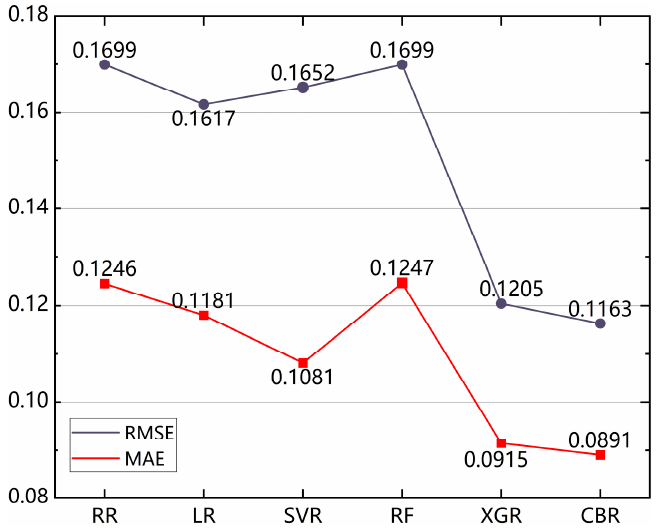
Figure 11. RMSE and MAE scores of the six regression models trained in all datasets.